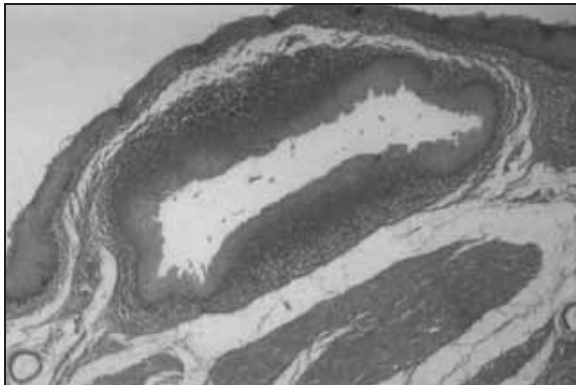
Figura 1 – Fotomicrografia destacando a localização superficial da lesão e o intenso infiltrado linfocítico na cápsula fibrosa (HE, 40 × ) HE: hematoxilina e eosina.